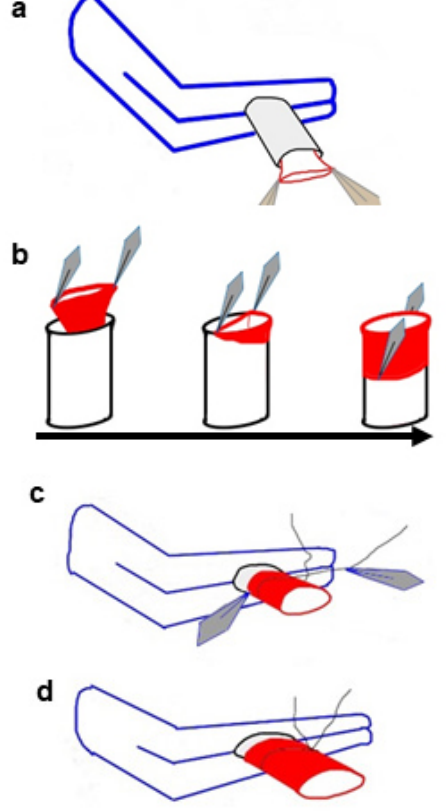
Fig. 2 - Diagram of vessel eversion. (A) The vessel is dragged into the cuff, and the vessel end is gently caught with two forceps bilaterally, while the cuff is perpendicular and clamped. (B) First, half of the vessel end is everted over the cuff, followed by the other half of the vessel end eversion. (C) A preset circumferential ligature encircles the everted vessel wall, and one end of the ligature is gently pulled to prevent slippage of the everted vessel wall. (D) The ligature is tied, and the vessel eversion is finished. The gray diamond represents the tip of the forceps; red represents the vessel